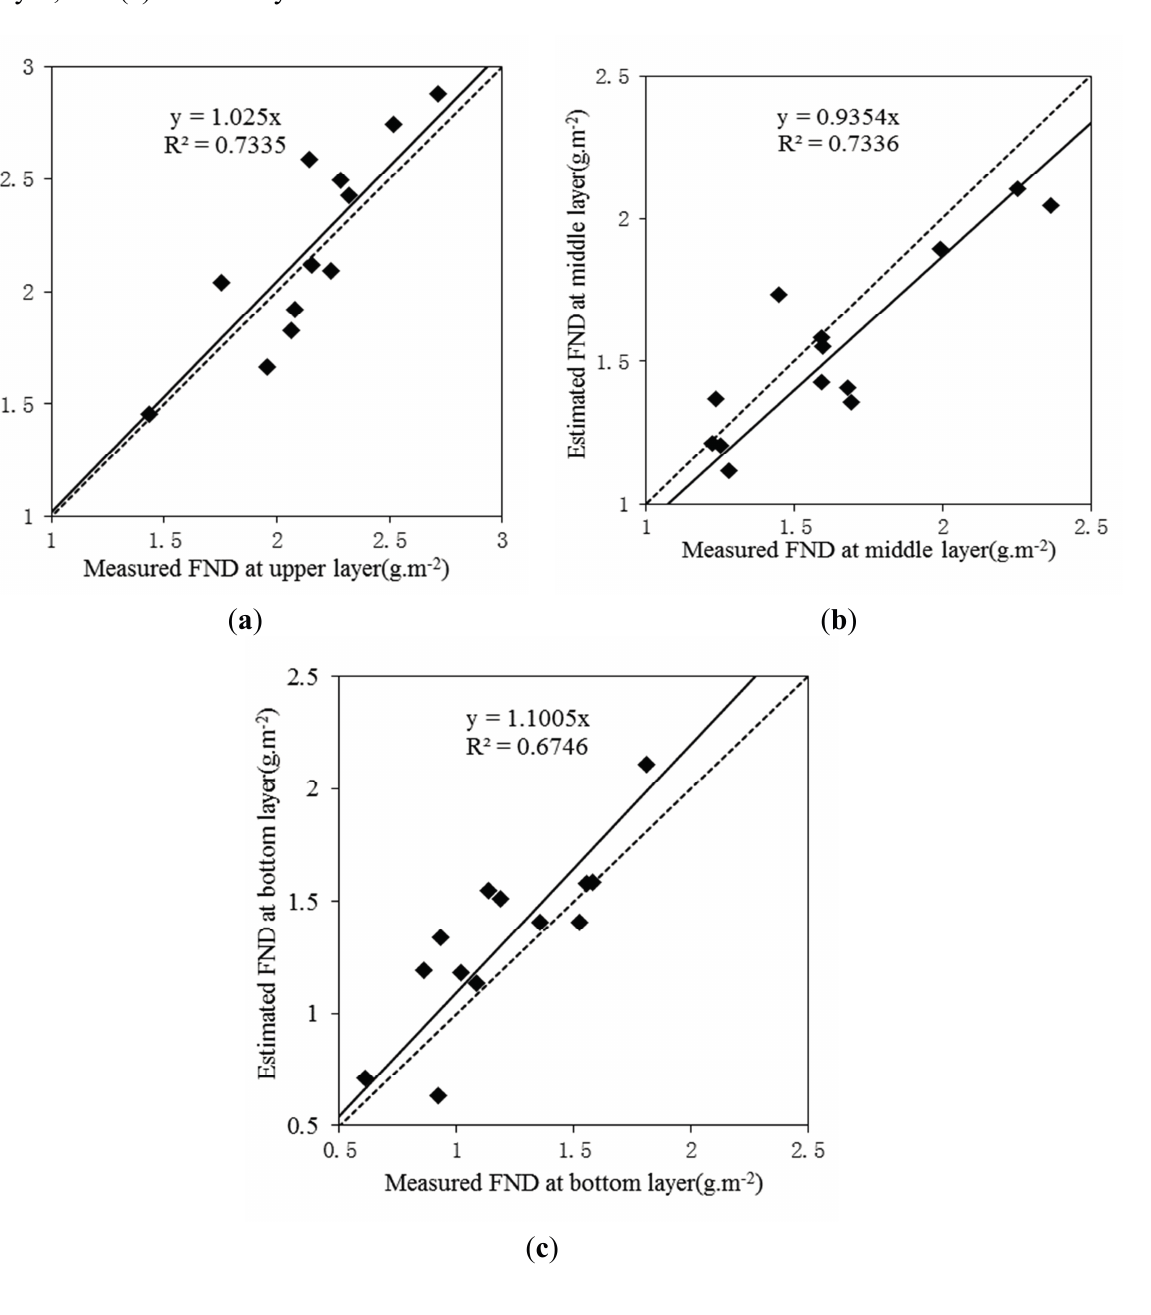
Figure 2. The best validated models ( n = 13) for each layer: ( a ) upper layer, ( b ) middle layer, and ( c ) bottom